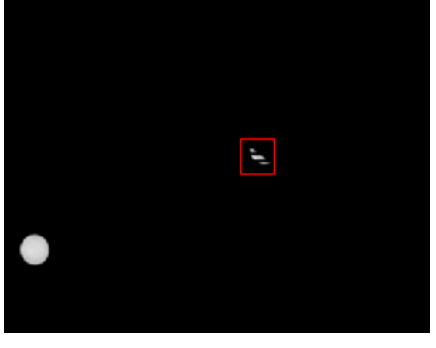
Figure 17. The tracking performance when most of the LED is shielded.